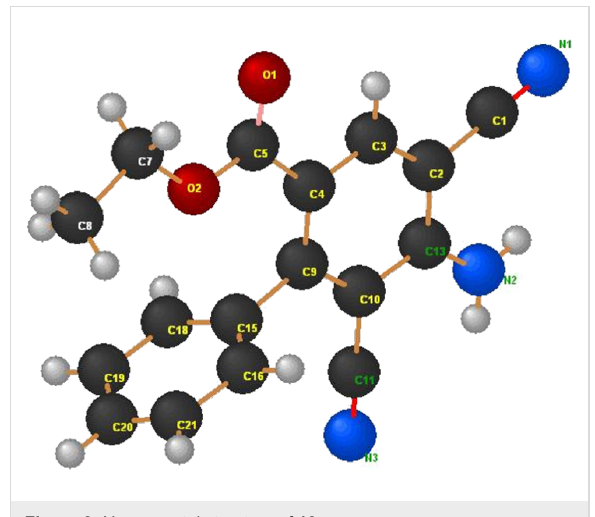
Figure 2: X-ray crystal structure of 13a